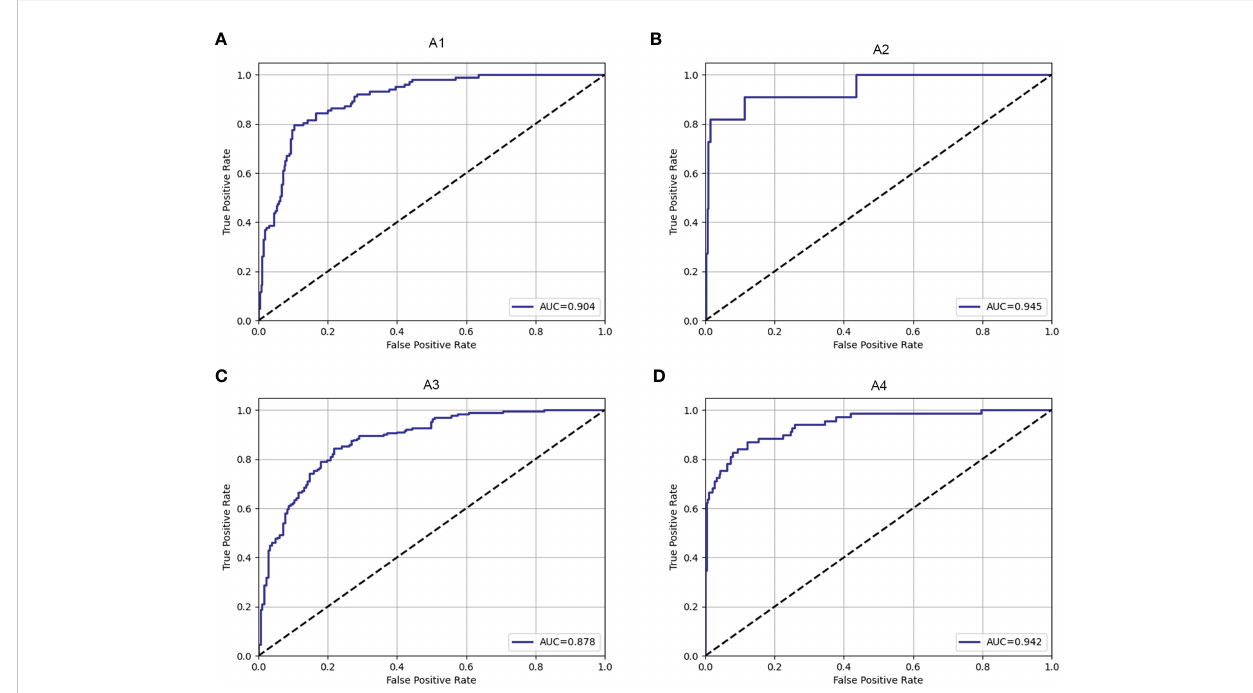
FIGURE 4 The ROC curve of fracture classi fi cation in the test dataset for type A1 (A) , type A2 (B) , type A3 (C) and type A4 (D)